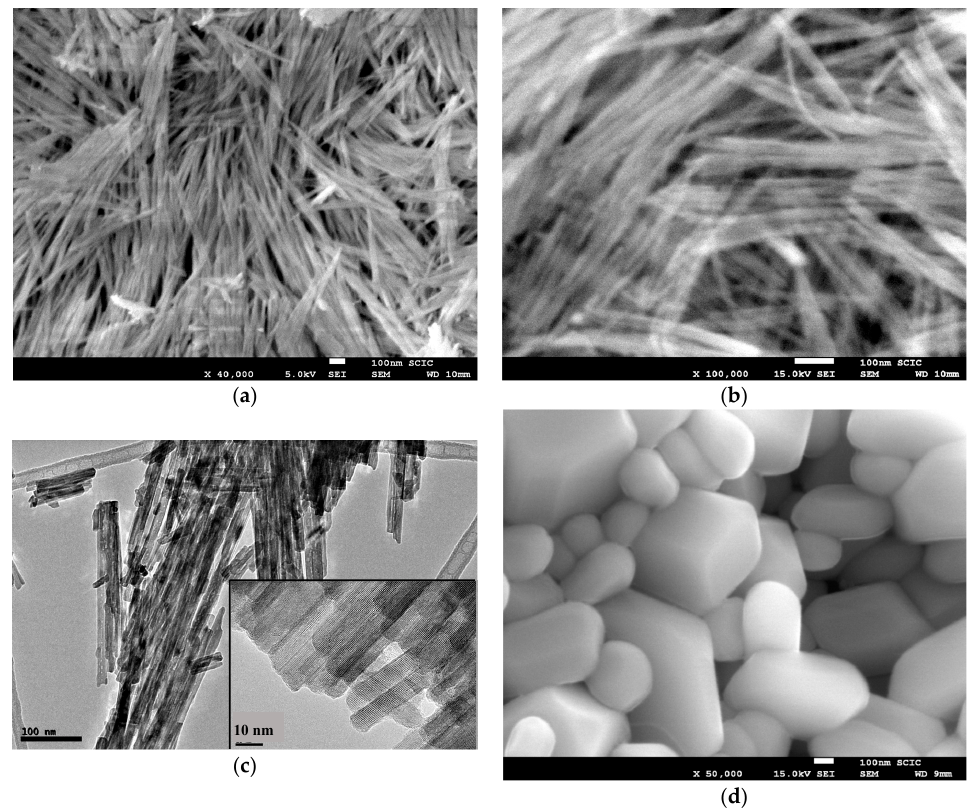
Figure 10. FE-SEM images ( a , b ) and TEM images ( c ) of templated nanofibrous CePO 4 annealed at 600 °C (air conditions); ( d ) FE-SEM image of templated CePO 4 annealed at 900 °C (air conditions).